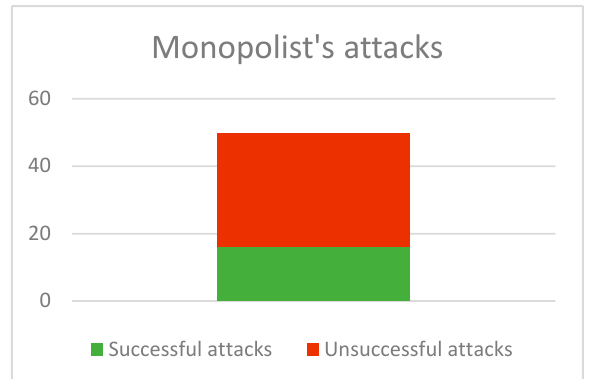
Figure 13. Chances of successful attack.